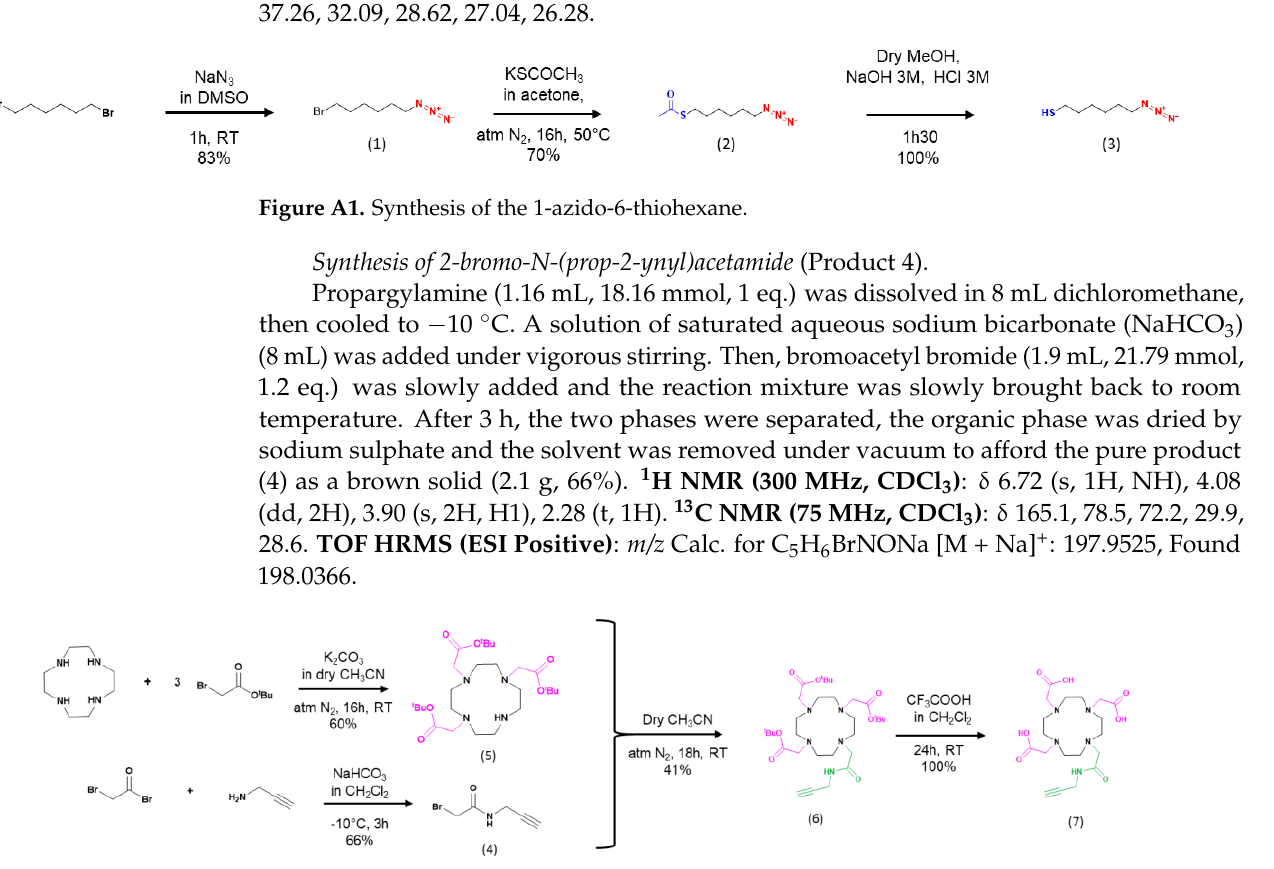
Figure A2. Synthesis of modified DOTA to immobilize DOTA on transistor .